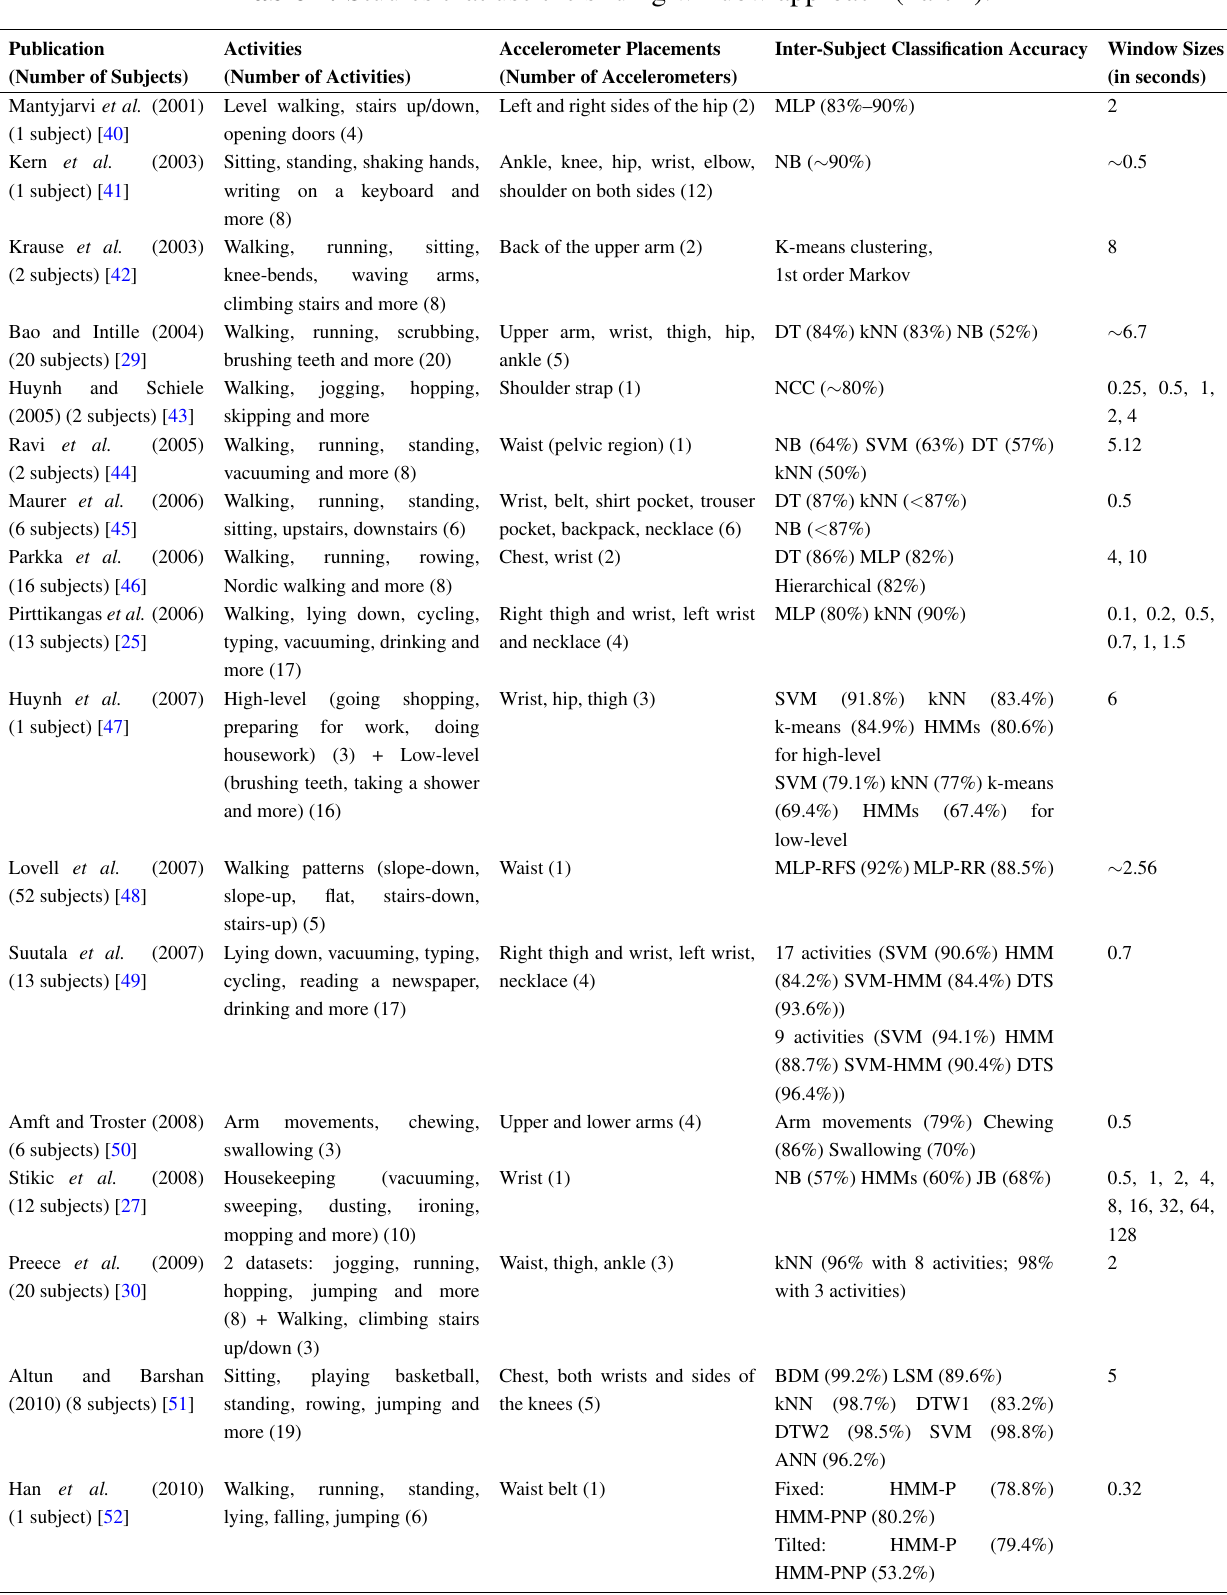
Table 2. Studies that use the sliding window approach (Part